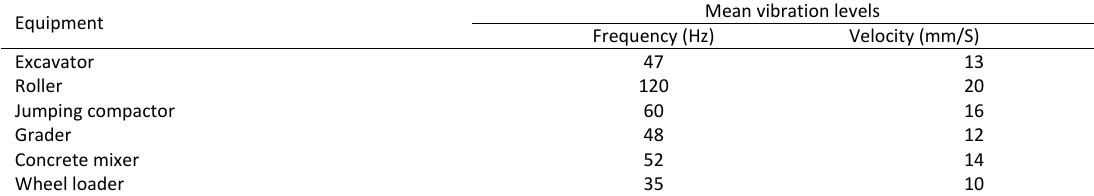
Table 4: Vibration levels of the respective equipment